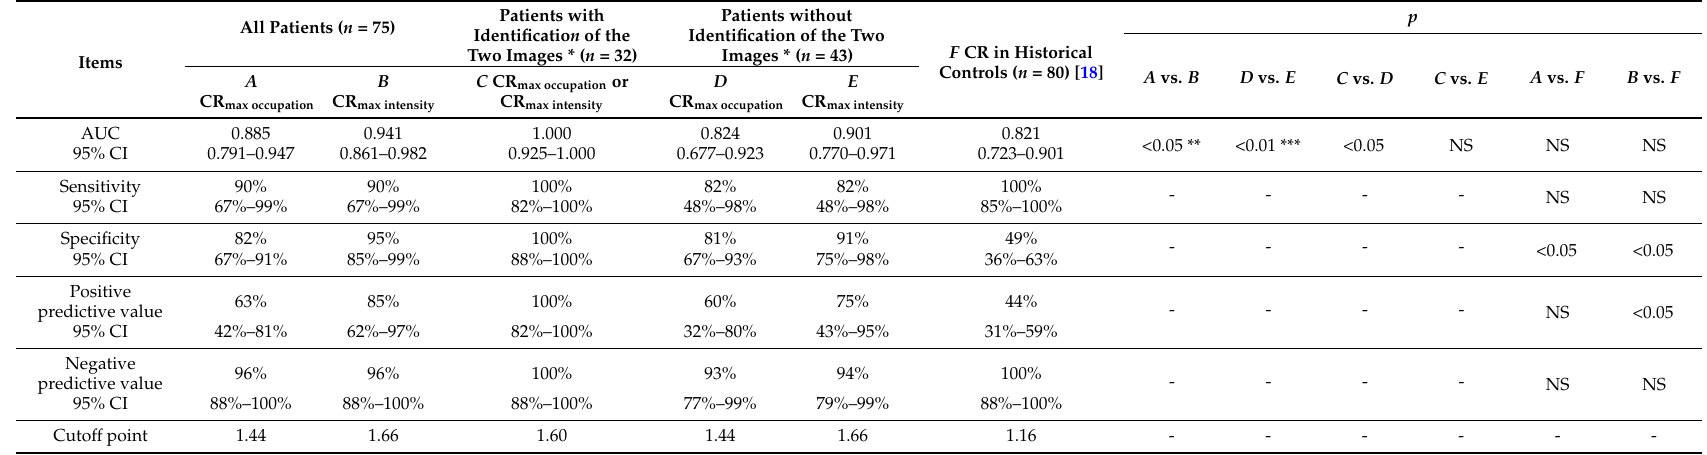
Table 2. Area under the ROC curve (AUC), sensitivity, specificity, and positive- and negative-predictive values for contrast ratio (CR) in the development of microembolic signals (MES) during exposure of the carotid arteries. NS, not